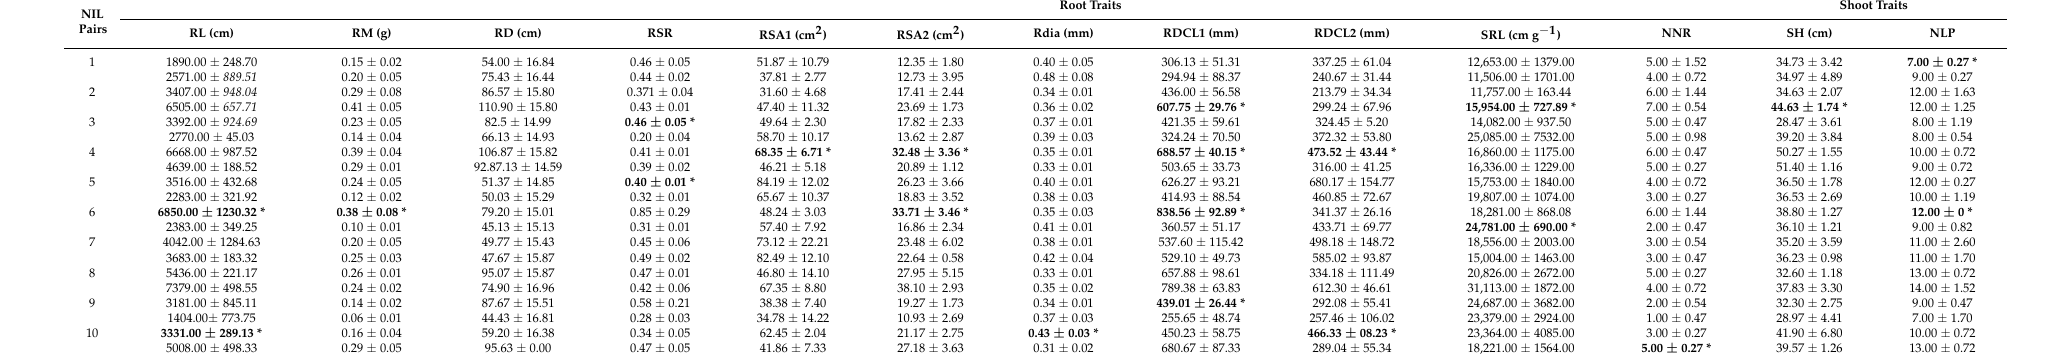
Table 2. Phenotypic performances (mean ± standard error) of wheat near-isogenic lines (NILs) used in this